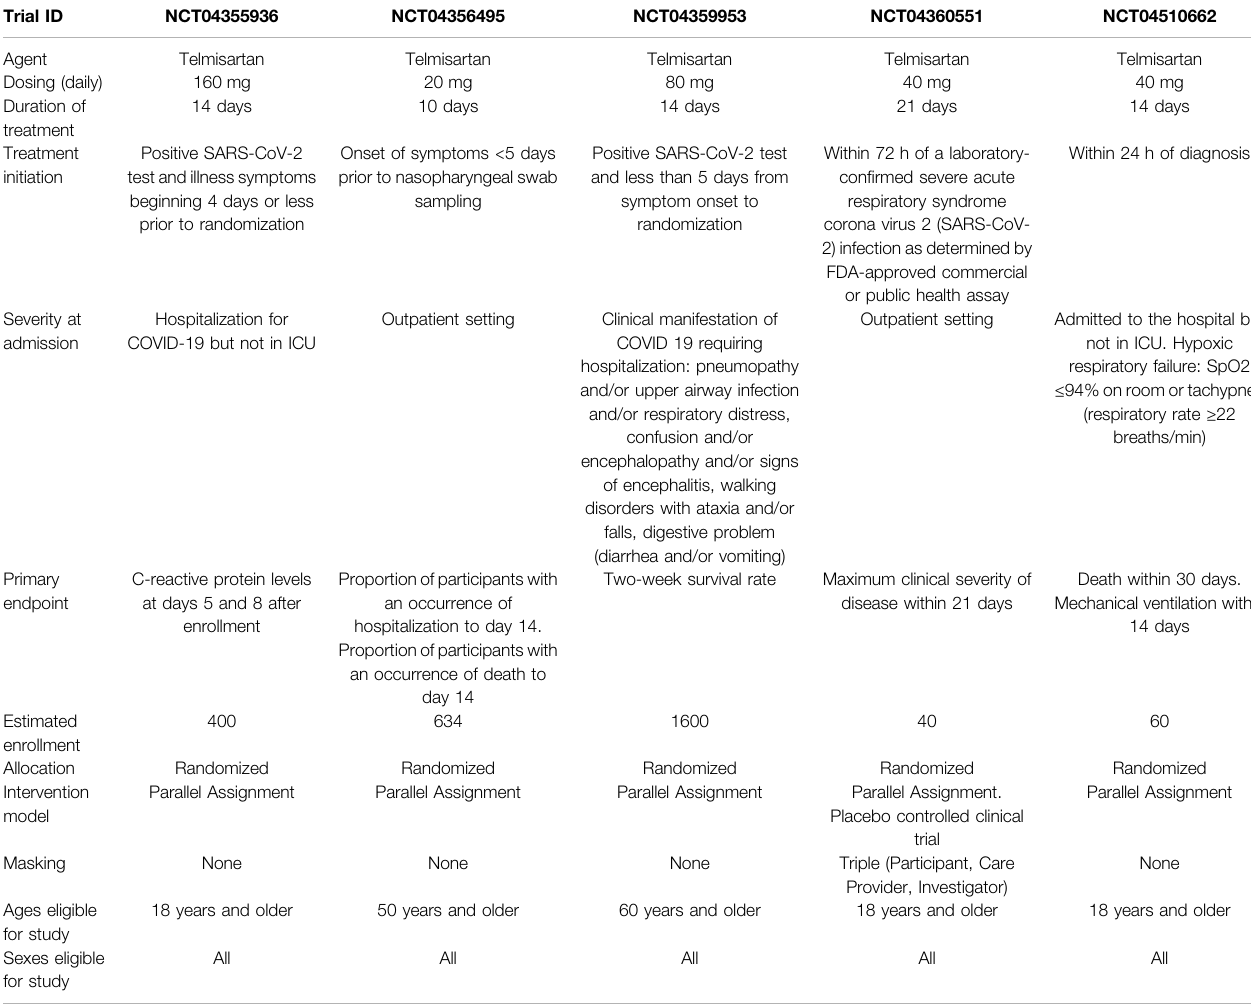
TABLE 2 | Main characteristics of telmisartan prospective clinical trials on